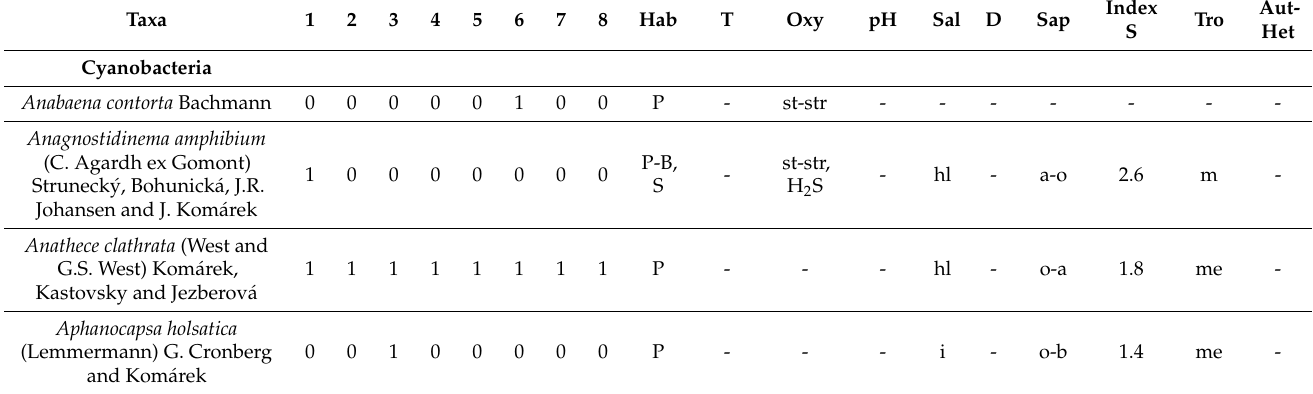
Table A2. Diversity of algae and cyanobacteria on the sampling stations (1–8) of the Lake Borovoe, 2019. Abbreviations: Hab , substrate preferences: B, benthic; P-B, plankto-benthic; and P, planktonic. T , temperature indicators: temp, inhabitants of temperate-temperature waters; and eterm, eurythermic. Oxy , Dissolved oxygen and water mobility indicators: str, inhabitants of streaming well-oxygenated waters; st-str, inhabitants of standing to streaming middle-oxygenated waters; st, inhabitants of standing low-oxygenated waters; H 2 S, sulfides anoxia indicators. pH , water acidity indicators: acf, acidophilic; ind, pH indifferent; alf, alkaliphilic; alb, alkalibiontes. Sal , salinity indicators: